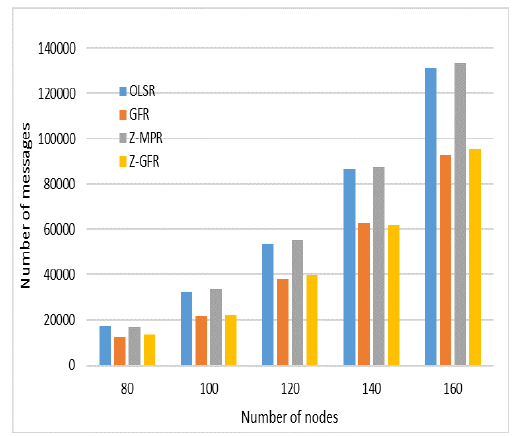
Figure 12. Number of generated TC messages.